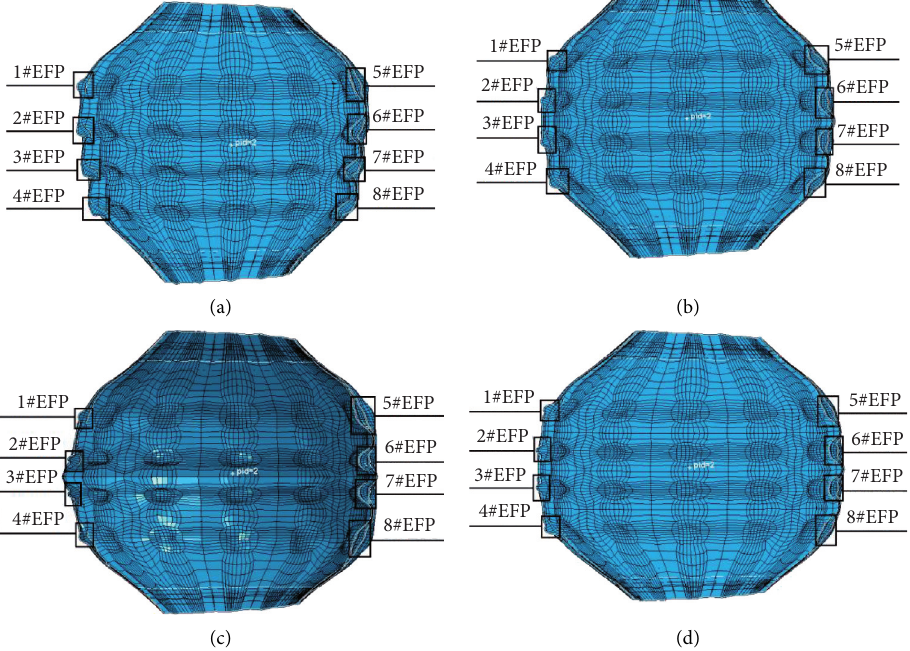
Figure 8: Forming results of single-column eccentric initiation.